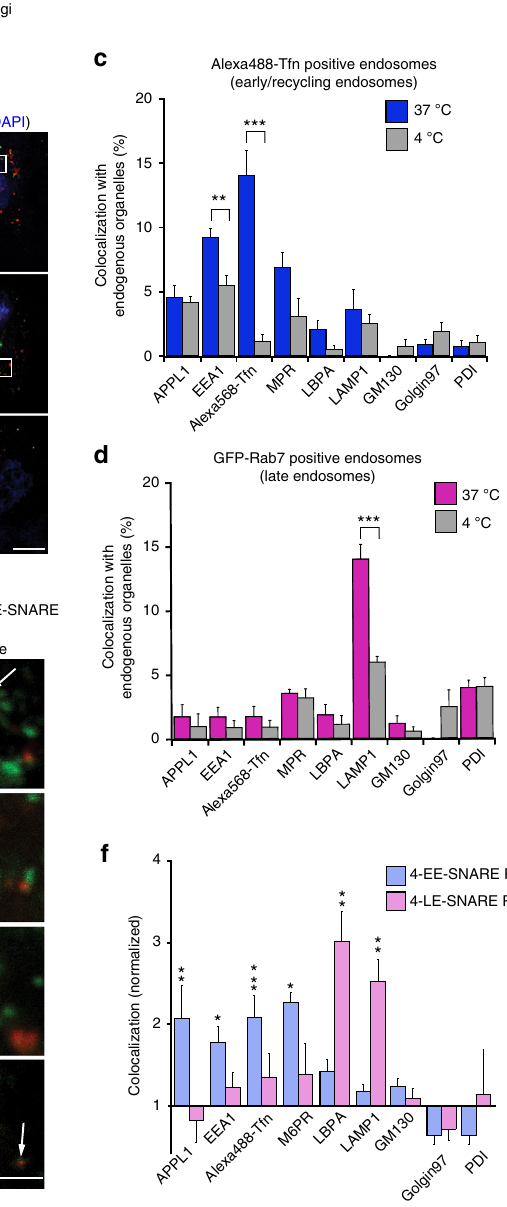
observation 23 . Note that the injected early/recycling endosomes were functionally active: when endosomes derived from cells expressing a Tfn receptor (TfnR) containing a luminal GFP-tag were injected, surface exposure of the Green fl uorescent protein (GFP) -tag was observable few minutes after injection (Supple- mentary Fig. 1e – h). Similarly, injection of late endosomes containing GFP-Rab7 resulted in speci fi c and signi fi cant co- localization with LAMP1 that was reduced at 4 °C (Fig. 1d